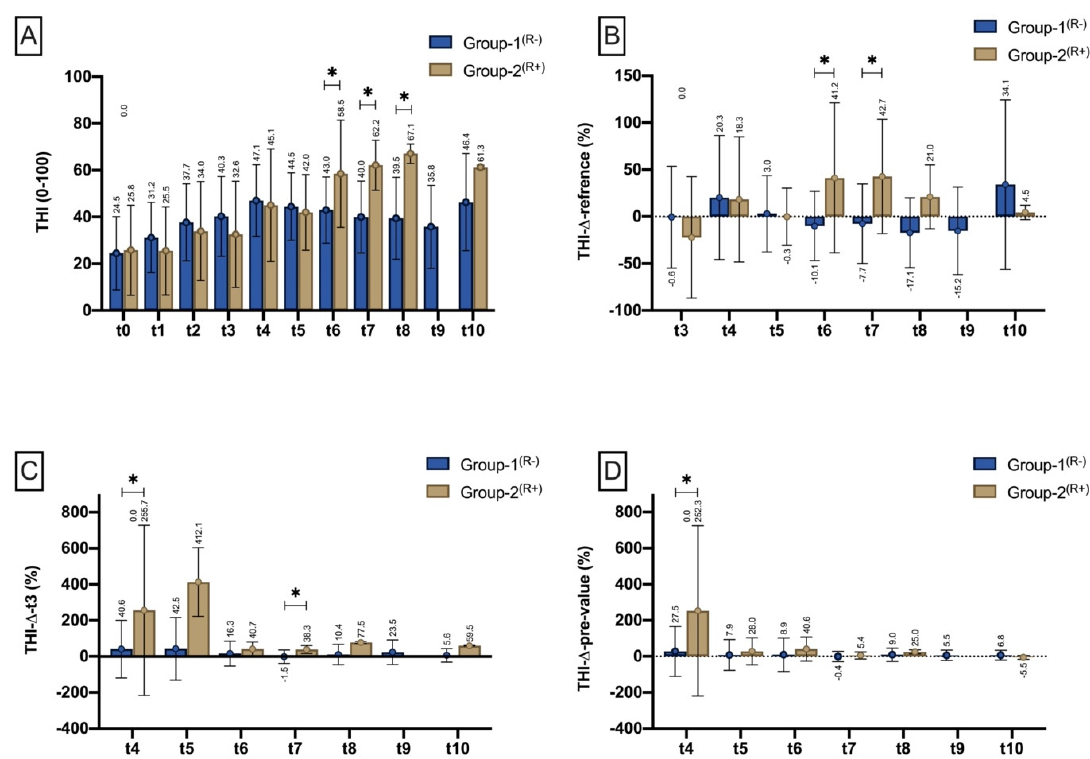
Figure 6. Bar chart with means ( ± SD) show THI at different measurement timepoints (t0–t3)/time intervals (t4–t10) as ( A ) (THI mean), ( B ) THI drop to reference (%) THI drop to the respective reference site (THI Δ reference), ( C ) THI drop to t3 (THI Δ t3), and ( D ) in relation to the pre-measurement (THI Δ pre-value). Means are shown scalar. Asterisk (*) marks existing significance.